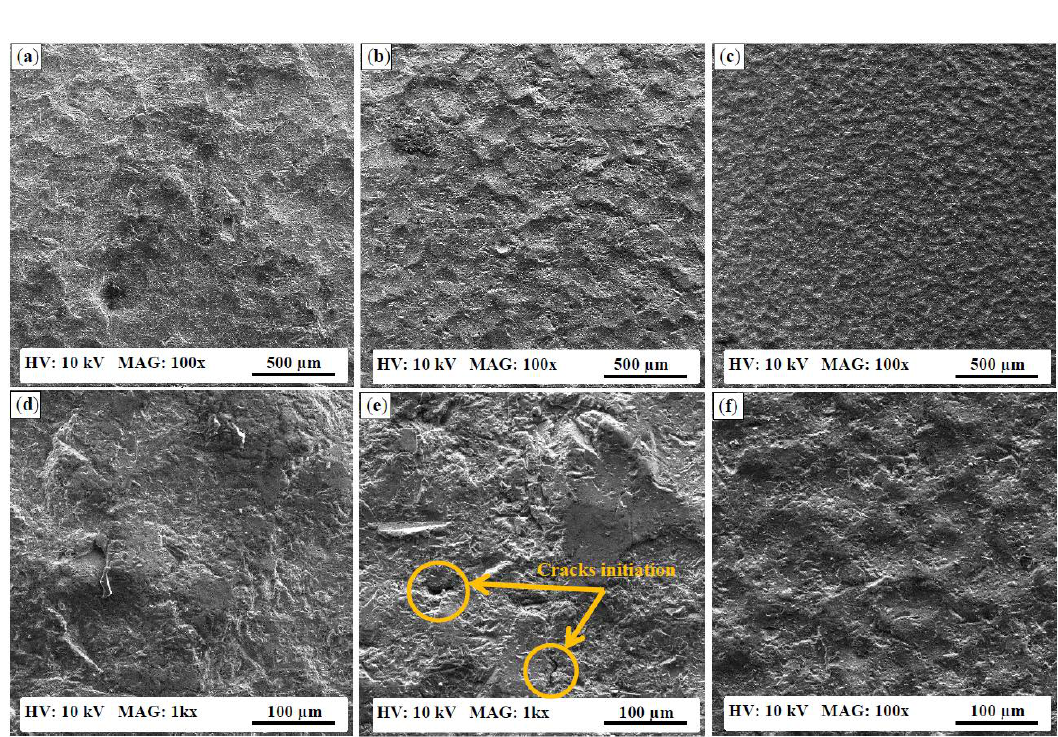
Figure 3. ( a ) SEM observations of the as-built AlSi10Mg surface defects, ( b ) partially melted powder particle, ( c ) ellipsoidal balling, ( d ) track of the strip laser scan, and ( e ) pore formed on the surface.